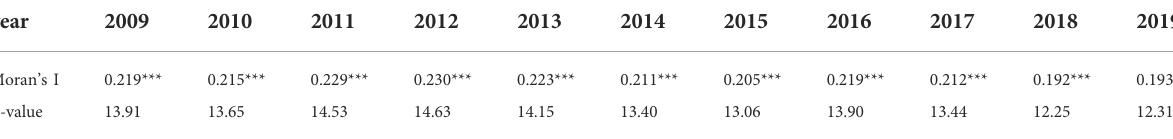
TABLE 2 Global spatial Moran ’ s I and the test results between the USFD and green economic